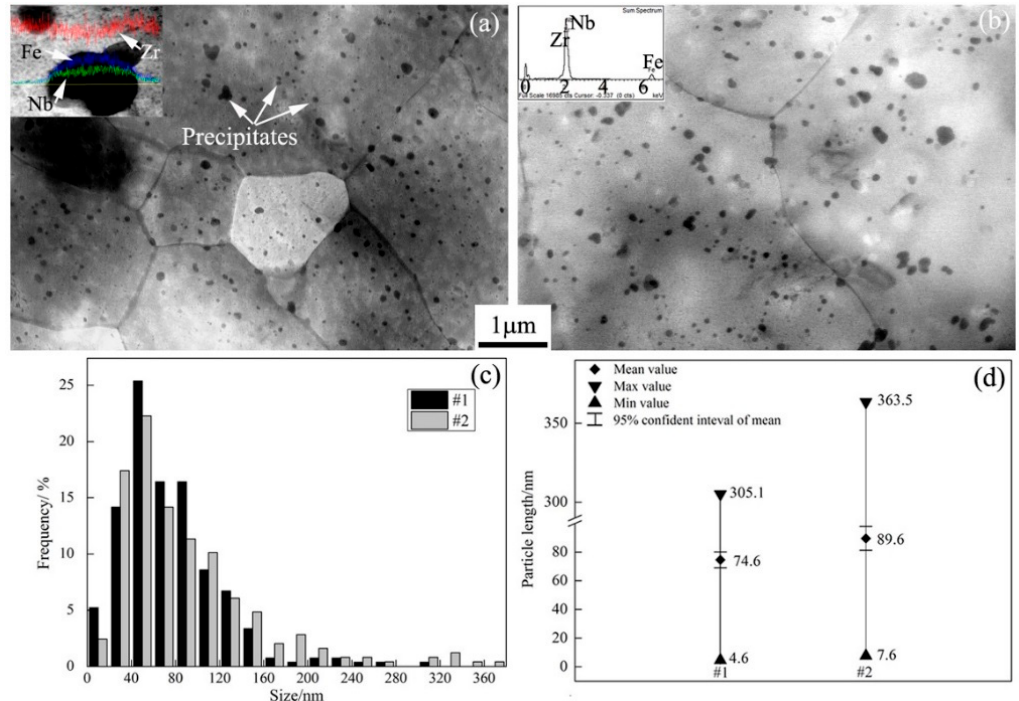
Figure 1. ( a , b ) STEM images showing the microstructure of the as-received #1 and #2 N36 Zr alloys, respectively; ( c ) the frequencies of particle lengths; ( d ) statistical results of the particle sizes.